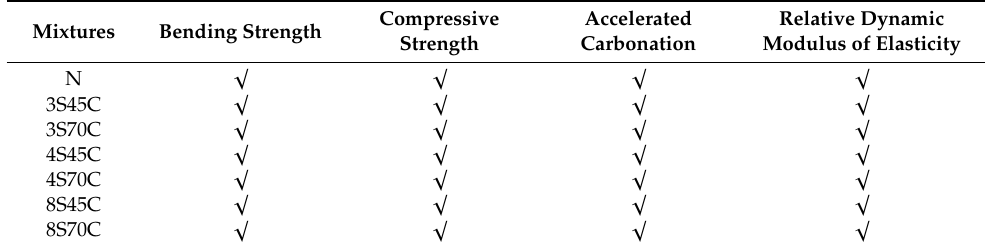
Table 4. Test items for measurement of self-healing